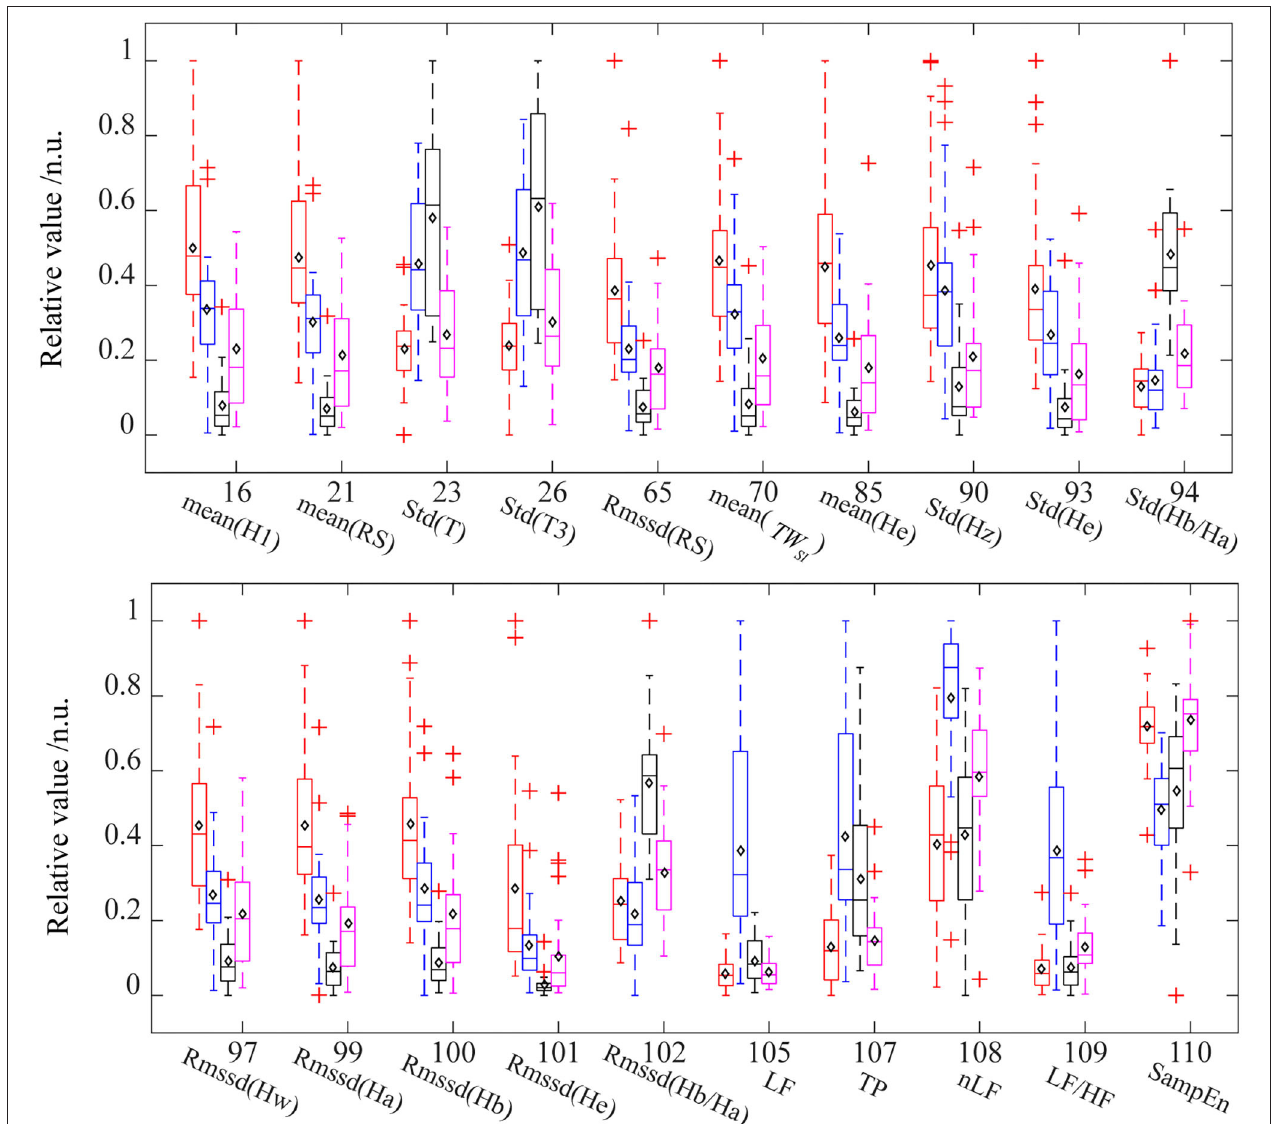
FIGURE 4 | The distribution of interpretation features in different ANS states. For each feature, the data were normalized between the four states. Red (baseline state, BSL), blue (slow deep breathing, SDB), black (cold pressor test, CPT), and pink (mental arithmetic test, MAT). The diamond mark represents the mean value. Std, standard deviations; Rmssd, root mean square of the successive difference; H1, height of the systolic peak; RS, rising slope of PPG; T, time span of the pulse; T3, diastolic time of the pulse; TW st , stress index; Hw, height of w point in VPG; Hz, height of z point in VPG; Ha, height of a point in APG; Hb, height of b point in APG; He, height of e point in APG; SampEn, sample entropy of pulse rate; LF, low-frequency power of PRV; TP, total power of PRV. nLF, normalized low-frequency power; LF/HF, ratio of LF to